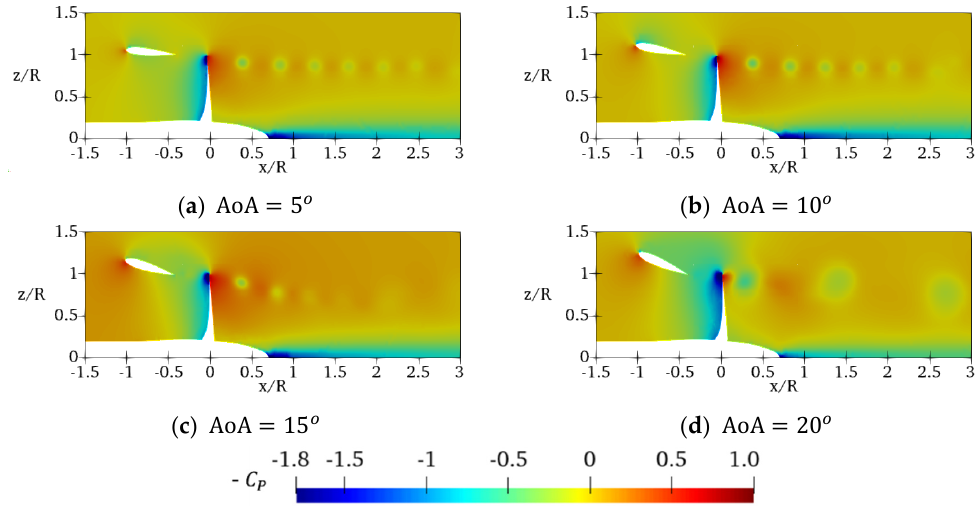
Figure 11. C P contours on longitudinal plane for cases with D D = D P Figure 11. 𝐶 (cid:3017) contours on longitudinal plane for cases with 𝐷 (cid:3005) = 𝐷 (cid:3017) . Figure 12 shows the cavitation shape for the propellers with 𝐷 (cid:3005) = 0.7𝐷 (cid:3017) . The vapor fraction of 0.5 was selected to visualize the cavity interface. Sheet cavitation was incepted at the leading edge and propagated to the downstream on the blade. The sheet cavitation was dominant on the suction side, with increased angles of attack. As the angle of attack increased, the cavitation inception radius decreased, indicating a large cavitation area. For 𝐷 = 0.7𝐷 (cid:3005) (cid:3017) , the inception points for AoA = 5° was observed to be approximately 0.75, while the inception point for AoA = 20° was approximately 𝑟/𝑅 = 0.65 . Figure 13 shows the cavitation shape for the propellers with 𝐷 (cid:3005) = 𝐷 (cid:3017) . A high angle of attack of the large duct increased cavitation around the tip region. The cavitation inception point moved up as compared to the propeller without the duct. The inception points of the case with 𝐷 (cid:3005) = 𝐷 (cid:3017) and AoA = 5° was observed to be approximately 𝑟/𝑅 = 0.75, while for the case with AoA = 20° , the inception point was observed to be at approximately 𝑟/𝑅 = 0.8 .